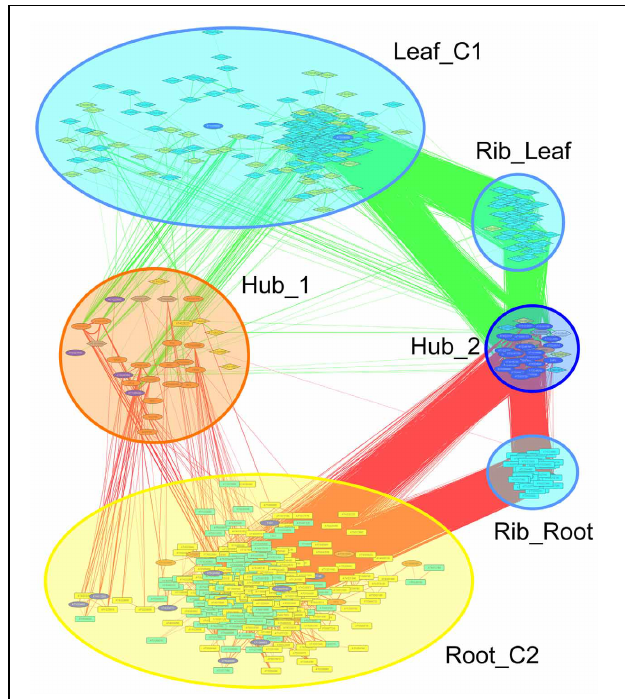
FIGURE 3 | Merged co-expression network of differentially expressed genes in roots and leaves. Differentially expressed genes were first clustered separately for roots and shoots based on their co-expression relationships with a Pearson’s coefficient of ≥ 0.60 against a customized data base that was constructed from experiments conducted with roots or leaves, respectively, using the MACCU software package, and then the two networks were combined. Yellow nodes denote genes that were up-regulated in roots or shoots, orange nodes indicate genes with increased expression in both organs. Light blue nodes denote genes that were down-regulated in roots or shoots, dark blue nodes indicate genes with decreased expression in both organs. Red and green lines represent co-expression edges derived from the root or leaf networks,